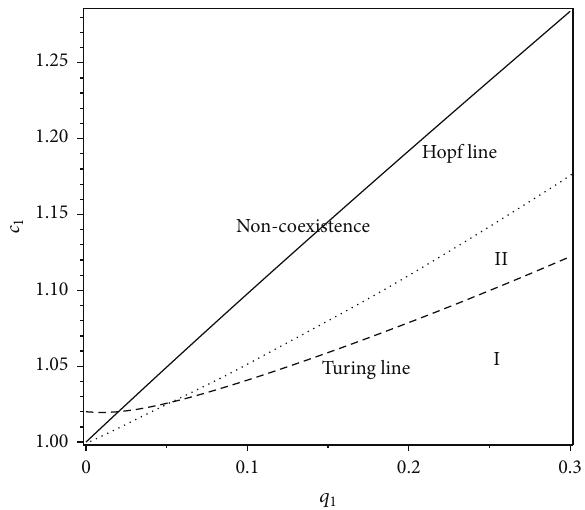
Figure 7: 𝑐 1 - 𝑞 1 bifurcation diagram for model (3) with 𝑚 1 = = 2 , 𝑞 = 1 , 𝑐 = 0.5 , 𝑑 = 0.01 , 𝑑 = 0.1 , 𝑑 = 1 and 𝑞 1.5 , 𝑚 2 2 2 1 2 3 1 ; the corresponding steady state is (𝑢 ∗ 1 , V ∗ 1 ,0) = (0.04667, 0.30333, 0) . ... : the dividing line of coexistence and noncoexistence of prey and their predators.